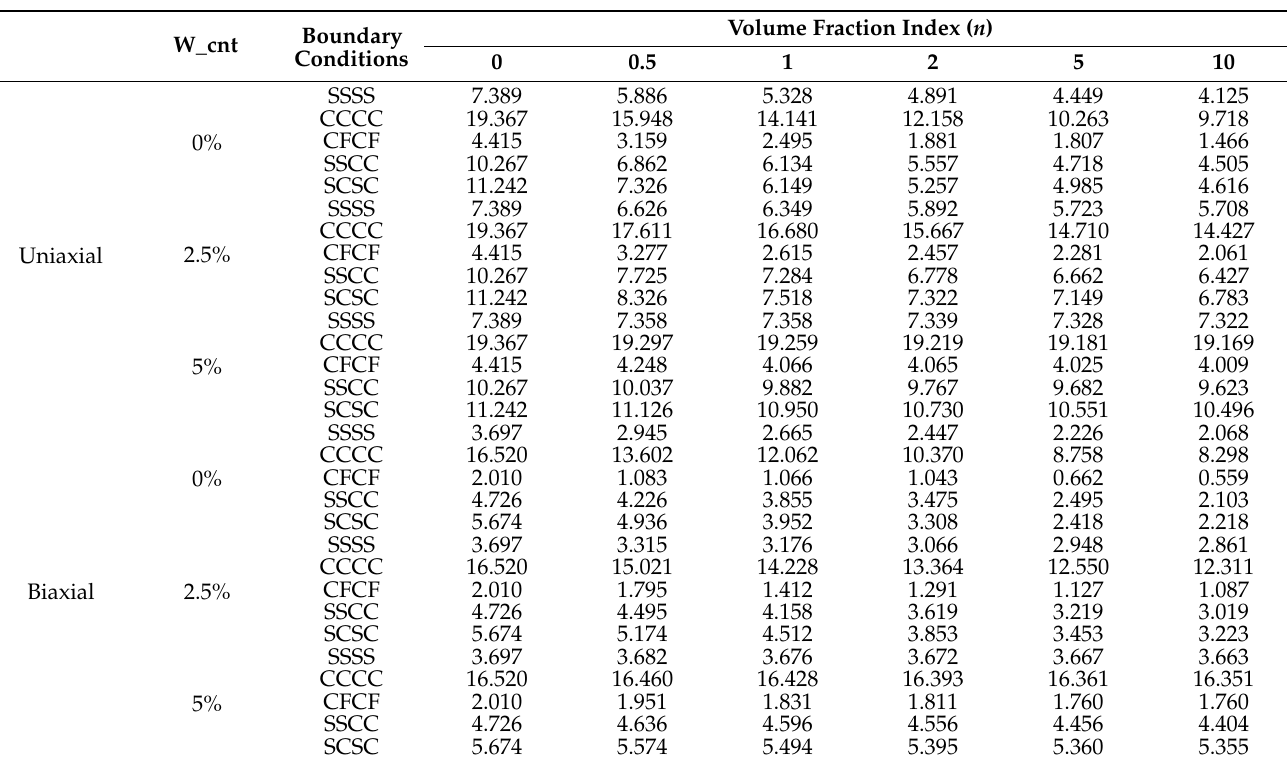
Table 4. Non-dimensional critical buckling load for different boundary